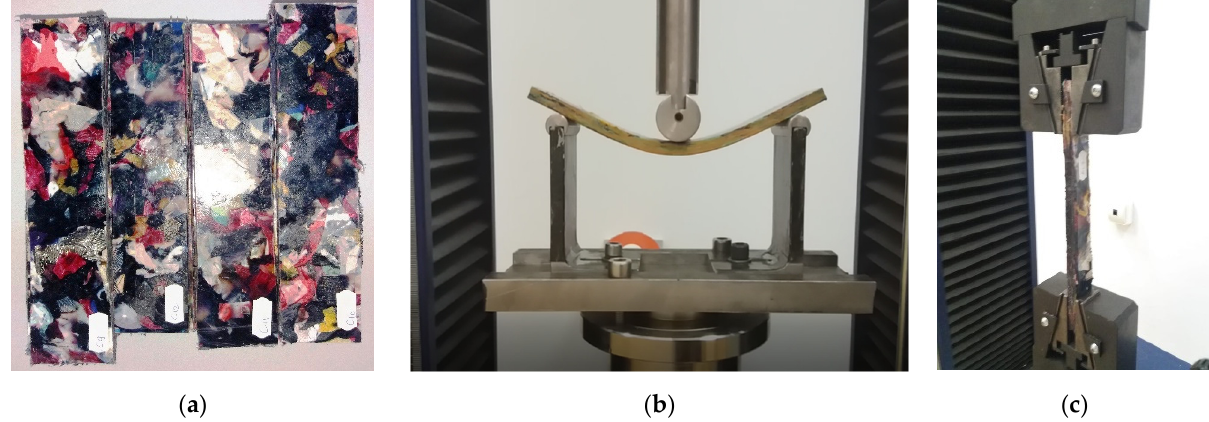
Figure 5. Mechanical properties testing (C9, C10, C11, C12): ( a ) tested samples; ( b ) compression testing; ( c ) stretch testing.